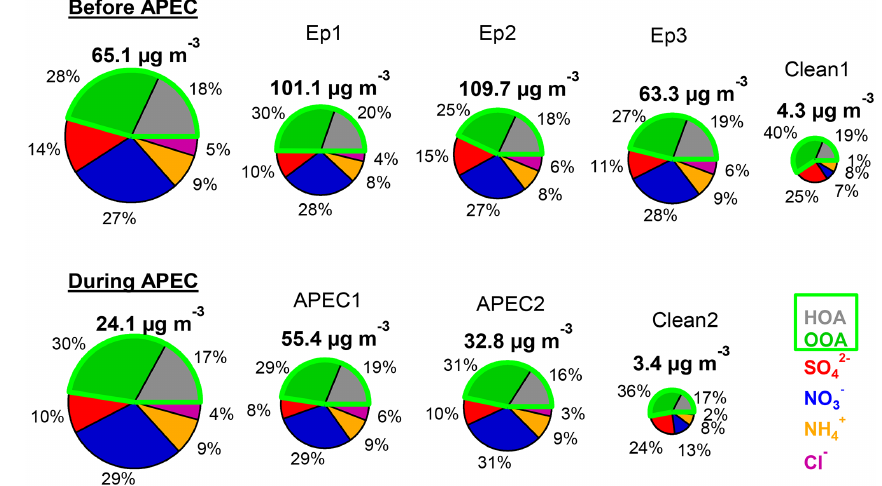
Figure 6. Average chemical composition of NR-PM 1 before and during APEC, and also that of five haze episodes and two clean events marked in Fig. 2.